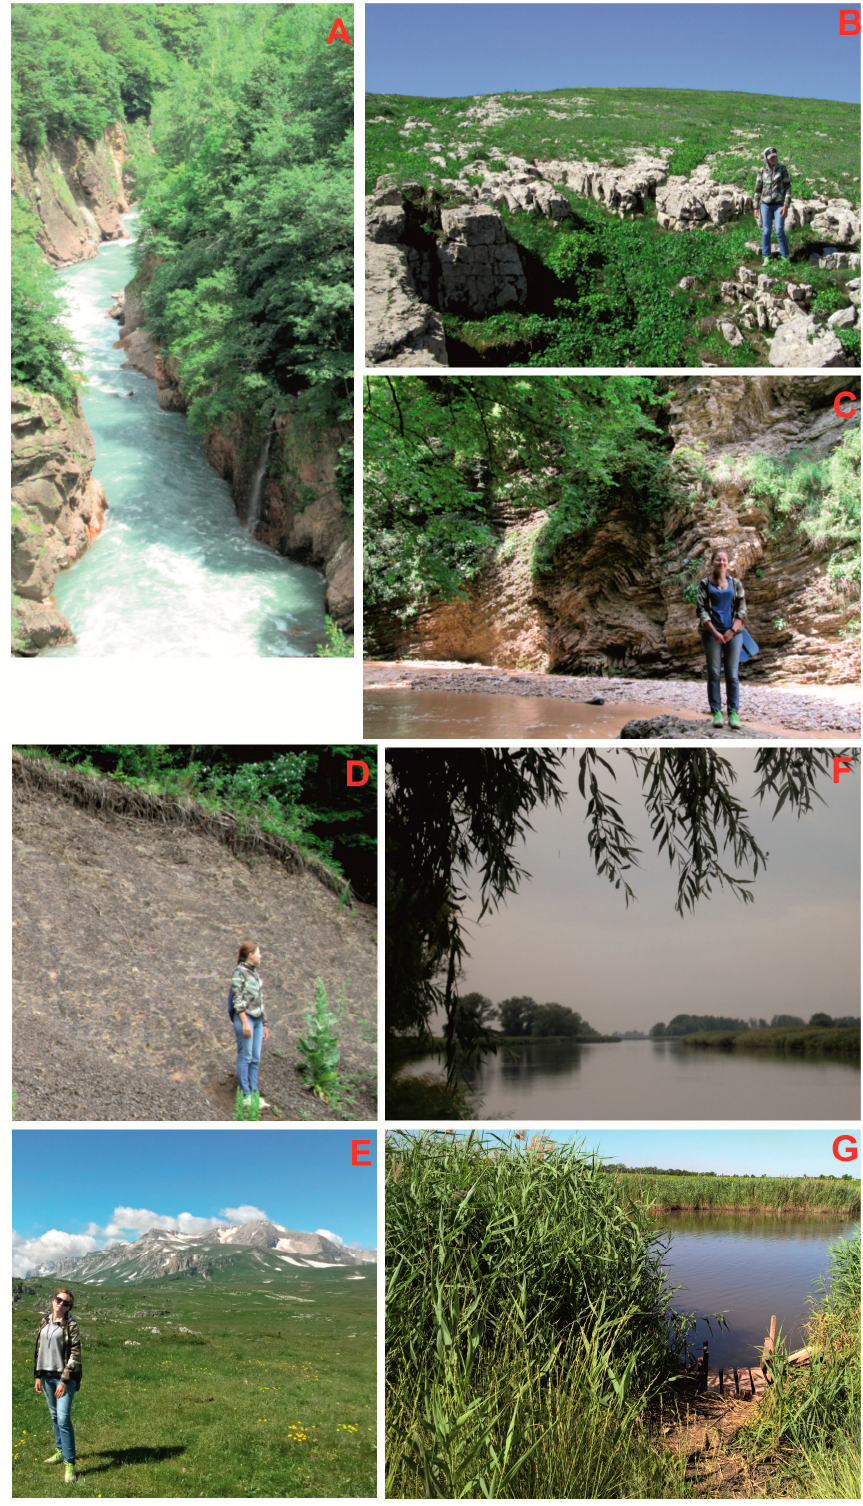
Figure 3. Geo-tourist attractions considered as case examples: ( A ) the Granite Gorge; ( B ) the karst sinkhole in the Lagonaki Highland; ( C ) the folded Triassic rocks in the Rufabgo Canyon; ( D ) the Jurassic deep-marine shales near the Partisan Glade; ( E ) the Oshten Mountain—a Late Jurassic reefal massif; ( F ) the Don River delta; ( G ) the Pelenkino mud lake (created by the authors; the author (A.V.M.) stays for scale on b-e); see Table 2 for more information.